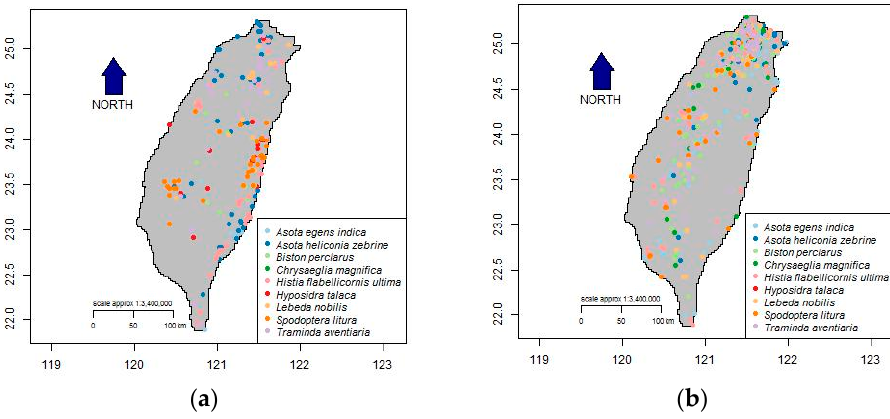
Figure 1. Focal species distribution from: ( a ) GBIF TaiBIF; and ( b ) EnjoyMoth Facebook data. Note: Global Biodiversity Information (GBIF) Taiwan portal dataset (TaiBIF).